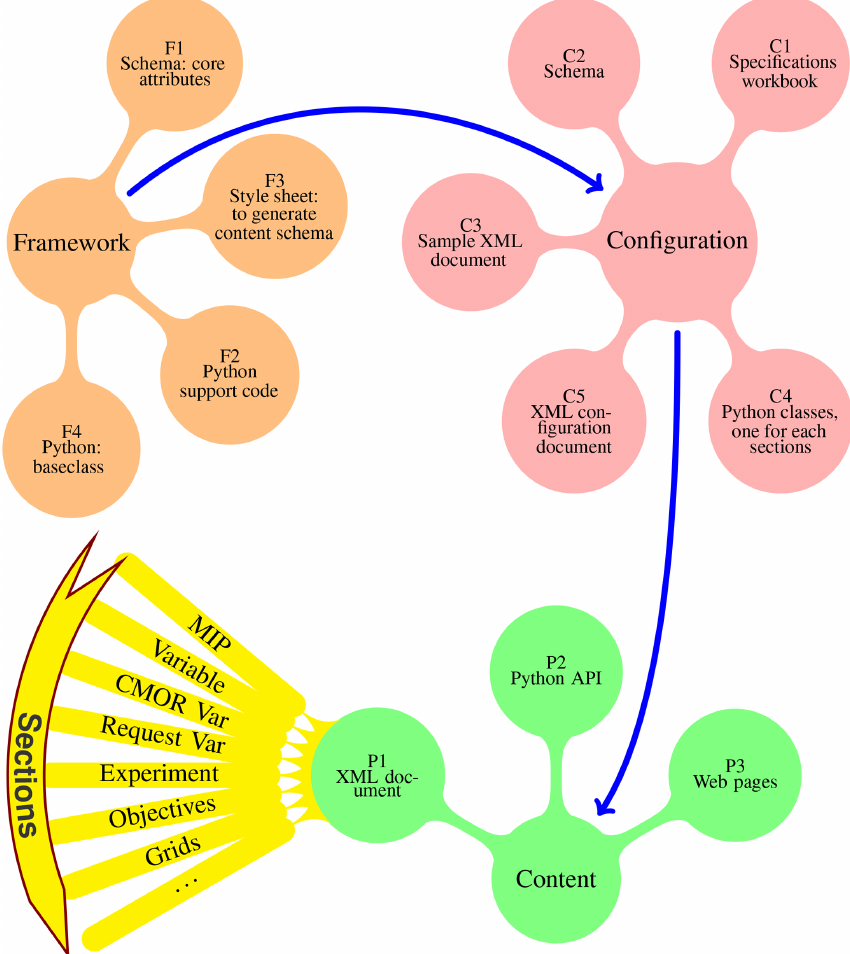
Figure 2. The schematic structure of the DREQ, showing the three key sections: Framework, Configuration and Content. F1: a set of core attributes are used to define additional attributes (see also Table B2); F2: a simple python script is used to manage framework information;